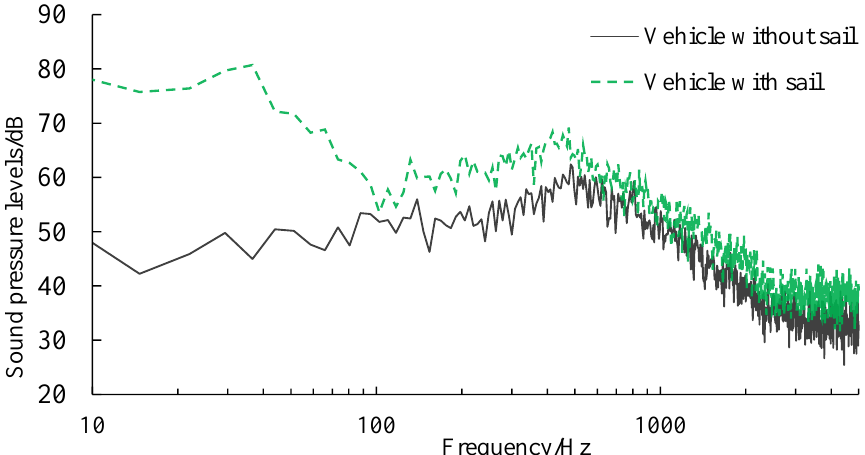
Figure 13. Spectrum of sound pressure levels at SZ9 characteristic points.